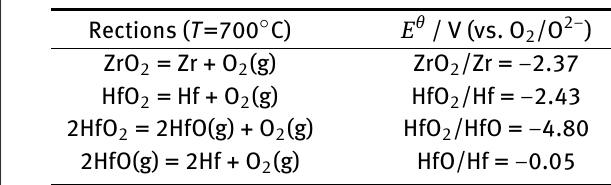
Table 1: The equilibrium electrode potentials of various